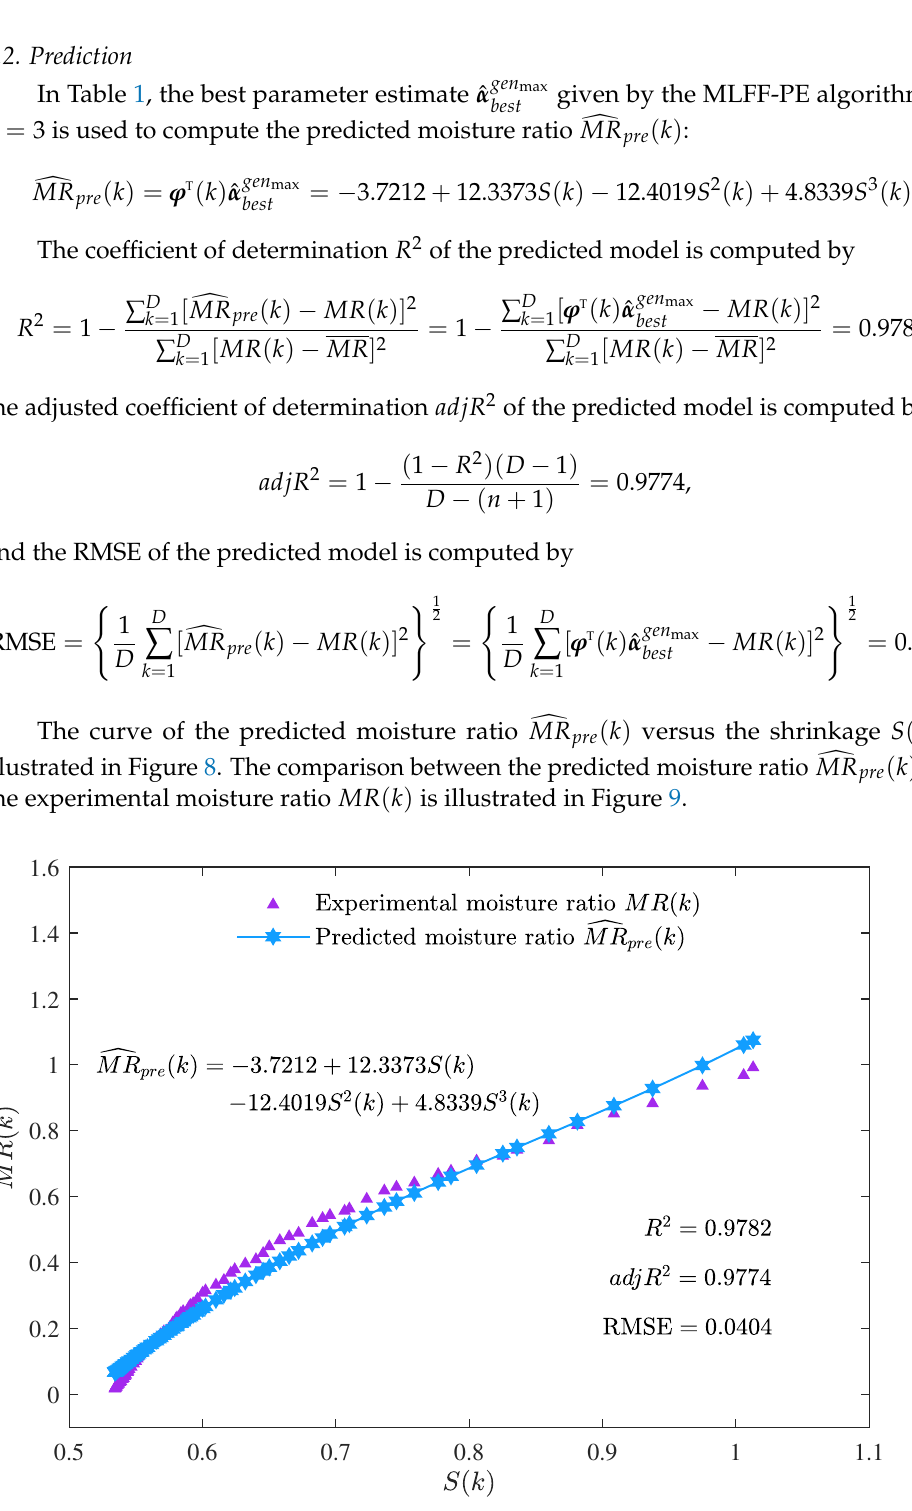
Figure 8. The predicted moisture ratio (cid:100) MR pre ( k ) versus the shrinkage S ( k )